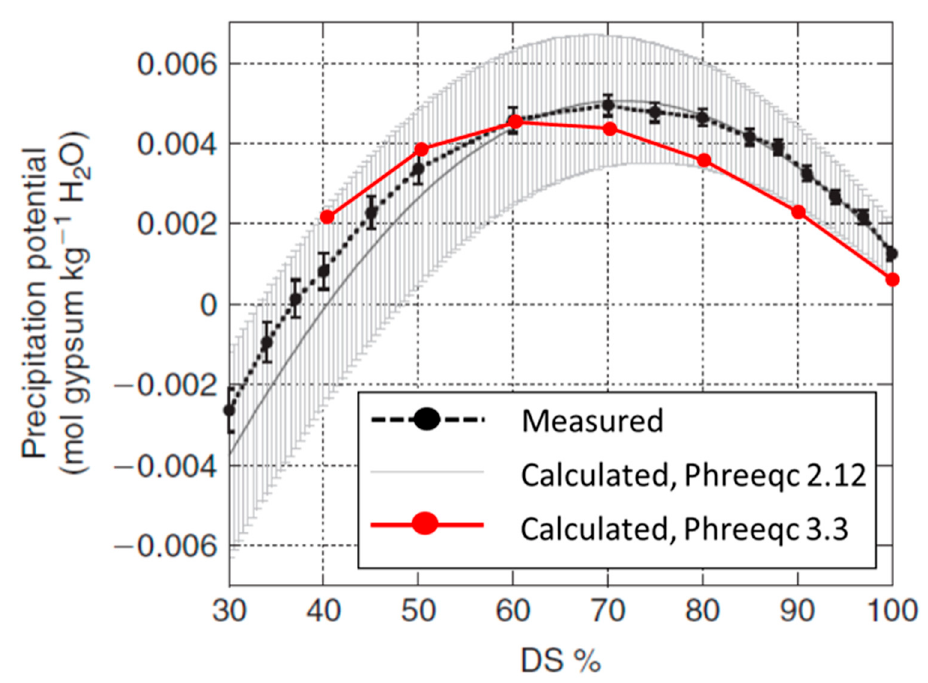
Figure 1. Experimentally-determined and calculated gypsum precipitation potentials from Dead Sea brine–seawater mixtures at T = 25 °C and P = 1 atm. The experimental data are derived from Reznik et al., [58]. Calculations are based on the two Pitzer.dat databases that were implemented in PHREEQC version 2.1 and 3.3. Figure reprinted from Rosenberg et al., [12] with permission of Else- vier.